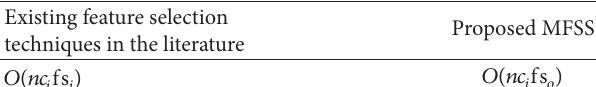
Table 10: Comparison of time